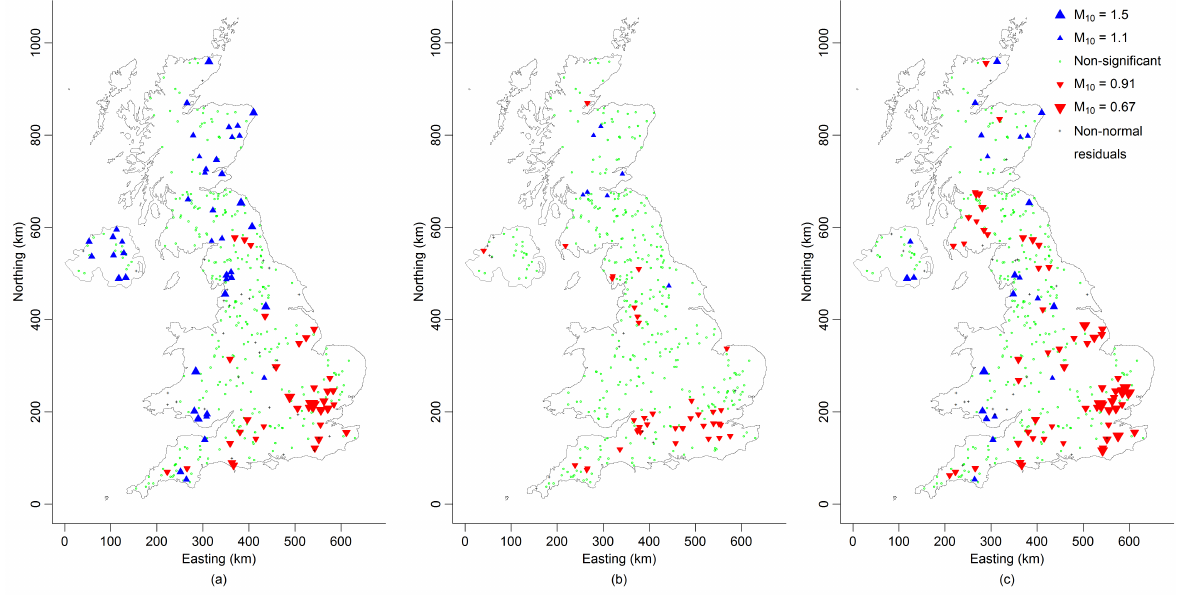
Fig. 10. Estimated decadal magnification factor M 10 for: (a) peak flow maxima with time as the only explanatory variable (model (a)), (b) daily rainfall maxima with time as the only explanatory variable, and (c) peak flow maxima with time and the 99th percentile of daily rainfall as explanatory variables – summer maxima